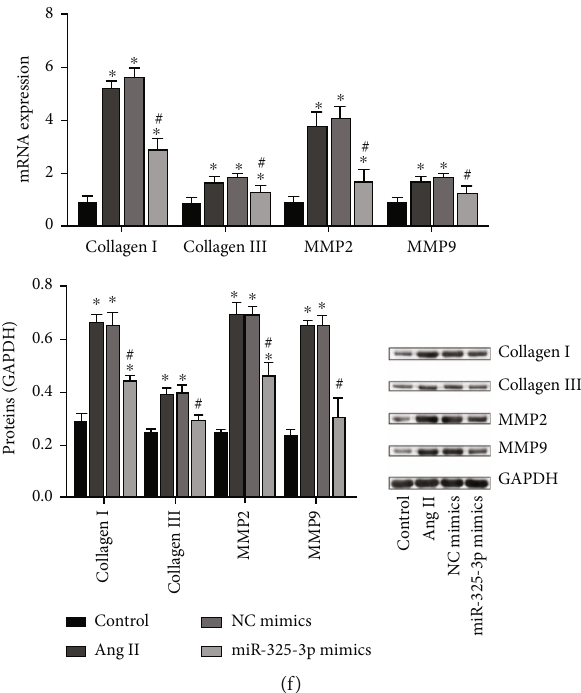
Figure 3: miR-325-3p-targeted regulation of HE4 to inhibit myocardial fi broblast fi brosis. (a) Starbase was applied to predict miR-325-3p and HE4 binding sites. (b) Dual-luciferase reporter assay experiments proved that miR-325-3p targeted HE4. (c) miR-325-3p and HE4 expressions were assessed by qRT-PCR. (d) Expression of Acta2 was measured by qRT-PCR. (e) α -SMA expression was detected by IF ( × 400, 25 μ m). (f) qRT-PCR and Western blot were utilized to detect collagen I, collagen III, MMP2, and MMP9 levels. ∗ P < 0 : 05 vs. control; # P < 0 : 05 vs. NC